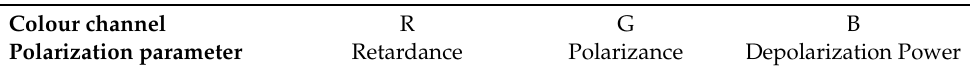
Table 2. Polarization staining in RGB colour space. Each colour channel is related to a physical